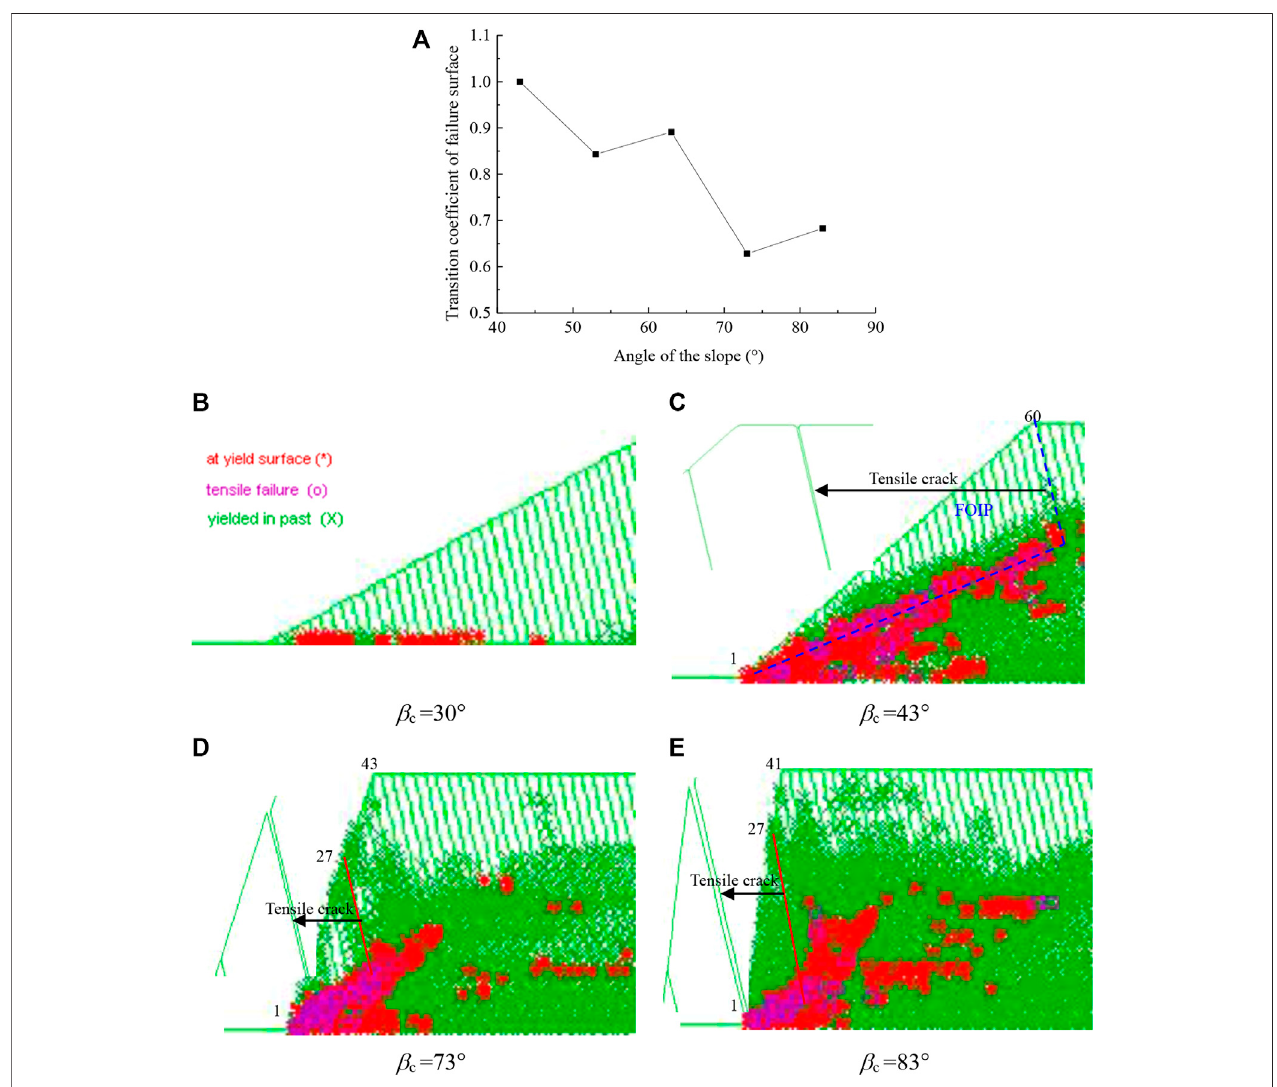
FIGURE12| Failure distribution oftheslopefordifferentslopeangles( β c ). (A) :Relationshipbetweenthetransitioncoef fi cientoffailure surfaceandtheslopeangle; (B – E) : The simulated plastic zone obtained using UDEC for different slope angles.